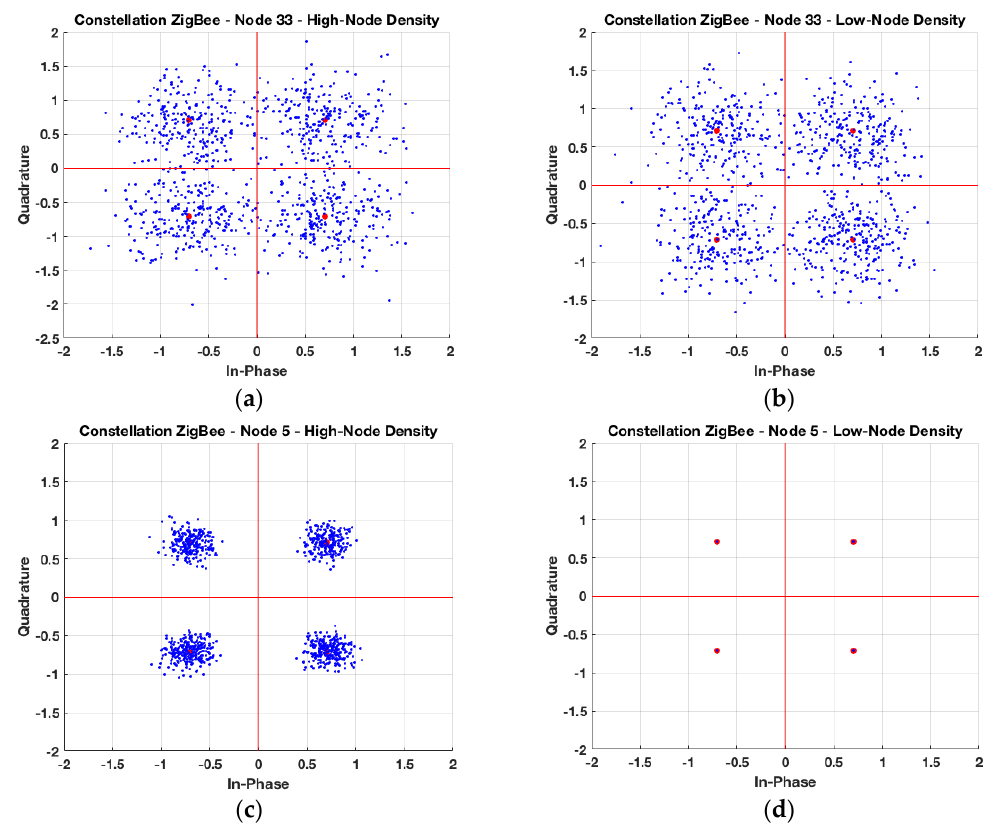
Figure 8. In Phase and Quadrature representation for two different nodes within the auditorium for offset-quadrature-phase-shift-keying (O-QPSK) modulation, ( a ) indoor node with high-node density scenario, ( b ) indoor node with low-node density scenario, ( c ) outdoor node with high-node density scenario, and ( d ) outdoor node with low-node density scenario.